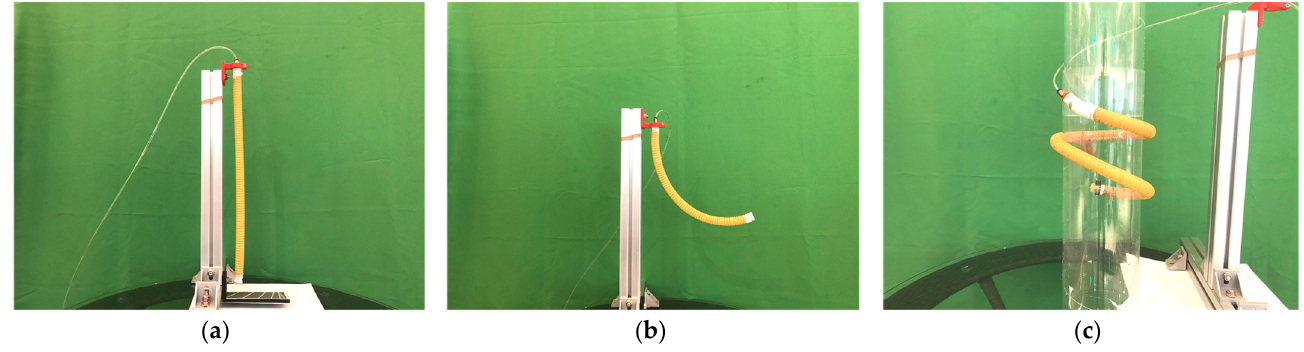
Figure 7. Forming effect of ( a ) extension, ( b ) bending, and ( c ) twisting modules.